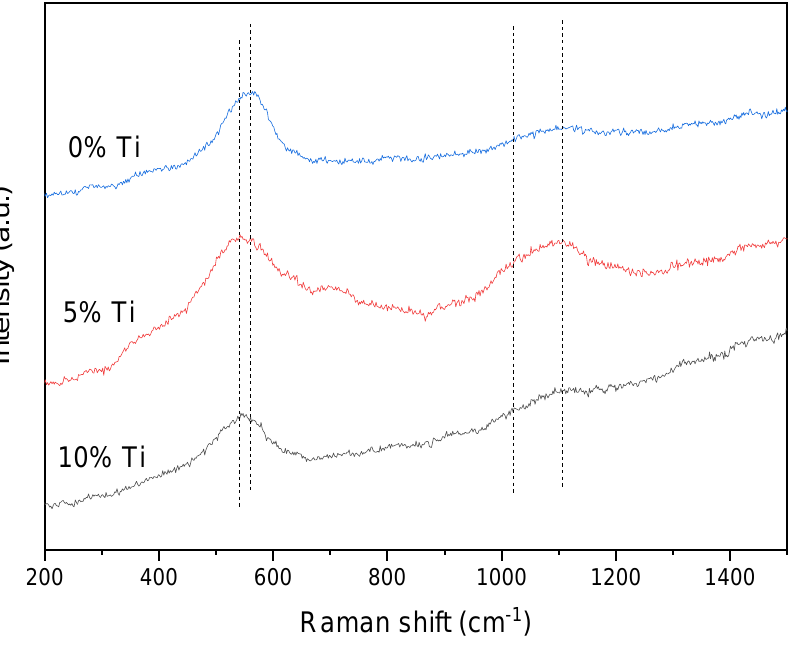
Figure 7. Raman spectra of the alloys with the addition of different Ti contents at 600 °C.